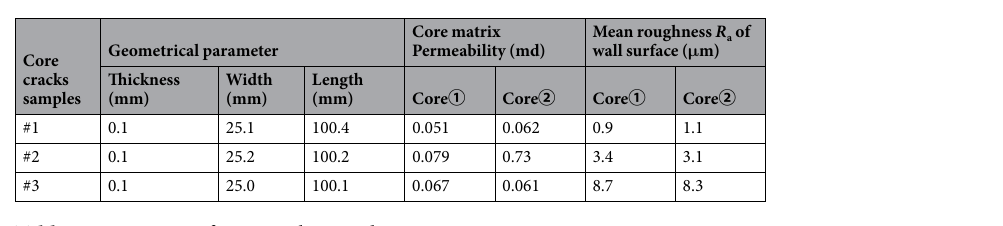
Table 1. Properties of core cracks